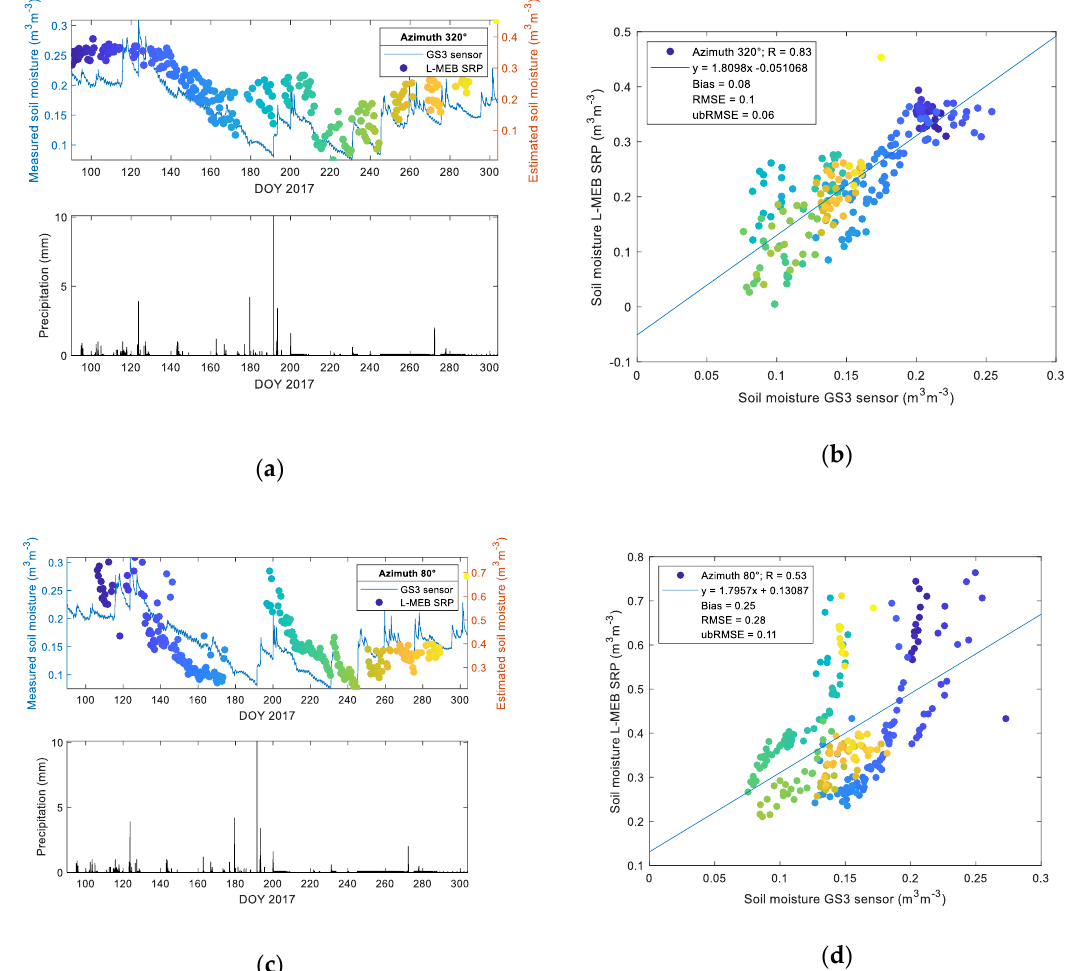
Figure 8. Time-series of estimated (dots) and measured (lines) SM vs. DOY 2017 (top) compared to the precipitation level (bottom) are depicted in panel ( a ) and ( c ). Correlative comparison of estimated and measured SM is shown in panel ( b ) and ( d ). Data are shown for azimuth 320° and 80° for low (4.5%) and high (10%) OM content, respectively. Colors of data-points in figure (b,d) indicate the moment in time for which SM was estimated, also shown in SM time-series in figure (a,c).